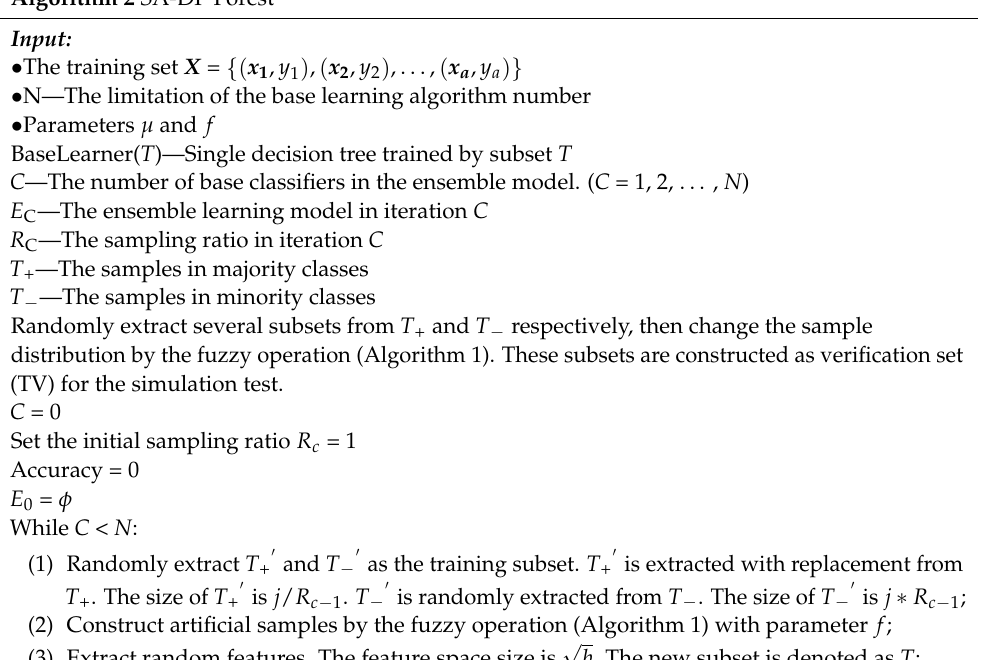
Algorithm 2 SA-DP